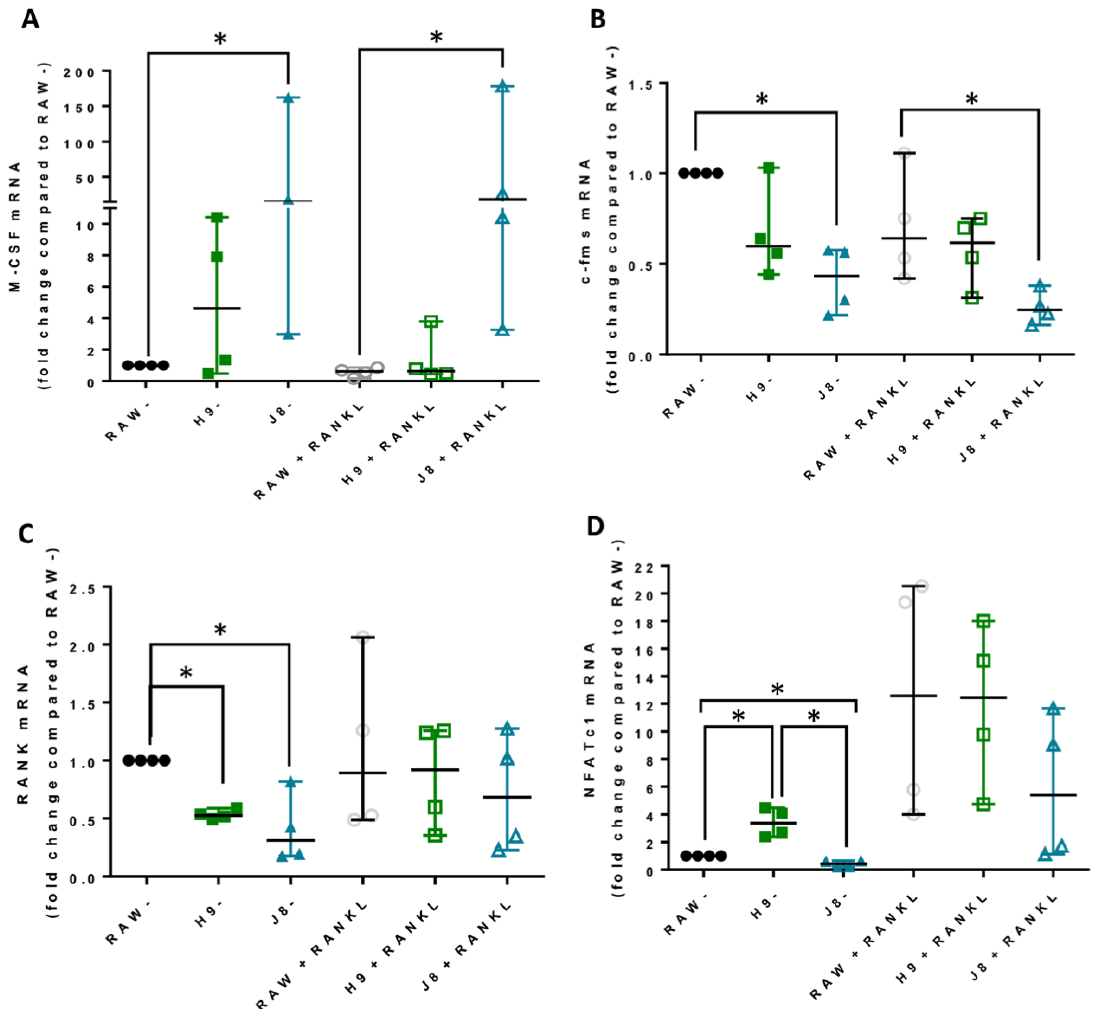
Figure 5. Gene expression of genes involved in osteoclastogenesis in unstimulated and RANKL-stimulated parental RAW264.7 and sub-clones H9 and J8. RAW264.7, H9 and J8 were stimulated +/− 10 ng/mL RANKL for 4 days after which mRNA expression of OC genes were measured ( n = 4). ( A ) M-CSF mRNA, ( B ) c-fms mRNA, ( C ) RANK mRNA and ( D ) NFATc1 mRNA. Data were analyzed with Kruskal Wallis followed by Dunn’s multiple comparison test. * p = 0.05. Values are given as median +/− range.